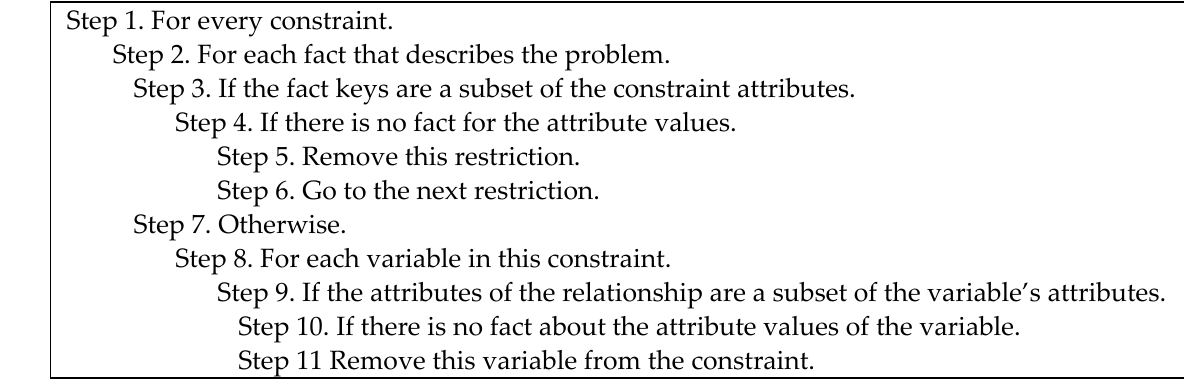
Figure 3. Procedure for reducing the size of the modeled problem (pseudocode).